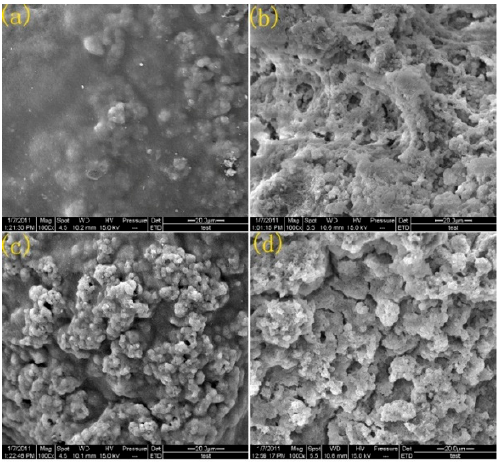
Figure 9. SEM micrographs (1000×) of the cone calorimetric residue for the composites, ( a ): S–